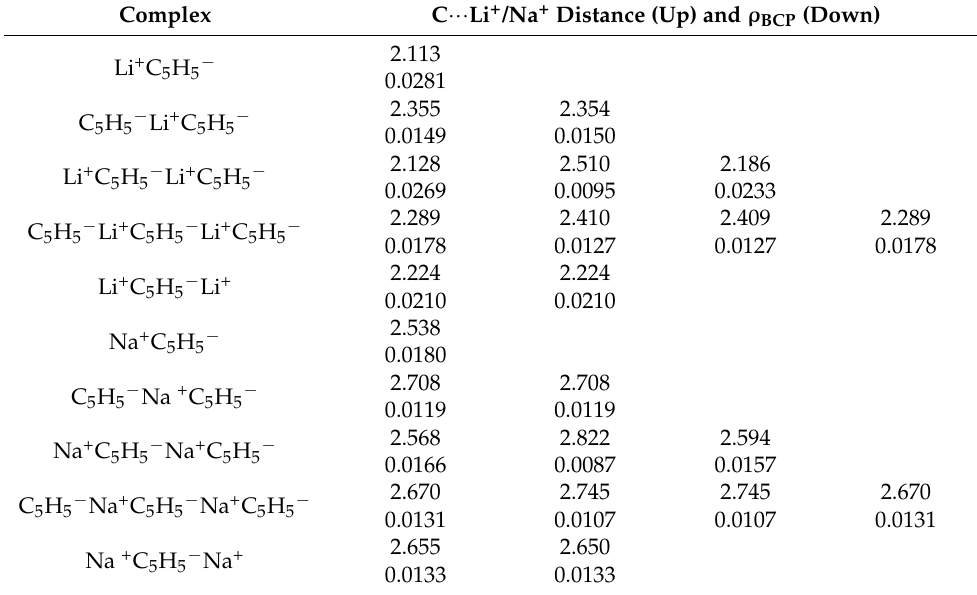
Table 3. The C ··· Li + /Na + distances (upper, mean values for each contact between the cation and the cyclopentadienyl anion, in Å) and the mean electron density (bottom values, in au) of the BCPs of corresponding carbon–cation bond paths, ρ BCP . The contacts are presented in the same order as for the designations given in the first column, i.e., from the left site to the right site. Complex C ··· Li + /Na + Distance (Up) and ρ BCP (Down) Li + C 5 H 5